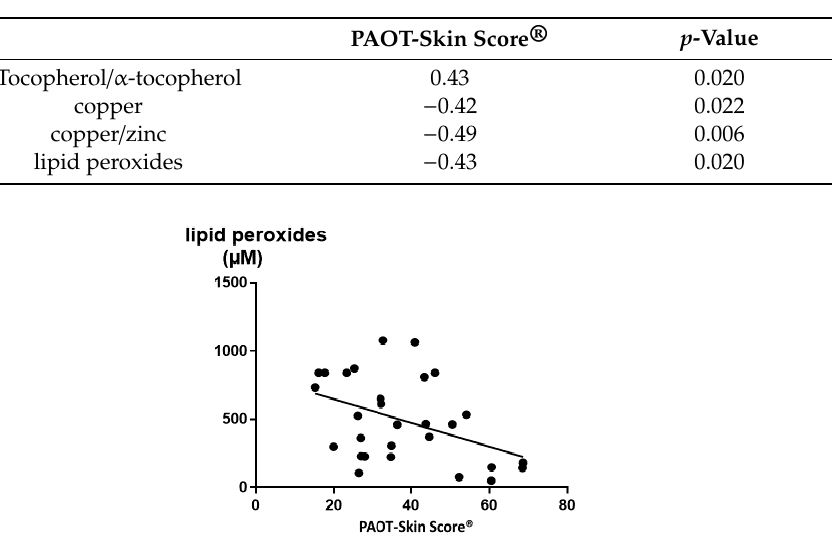
Table 6. Significant correlations found between PAOT-Skin Score ® and blood OS biomarkers (Group III).